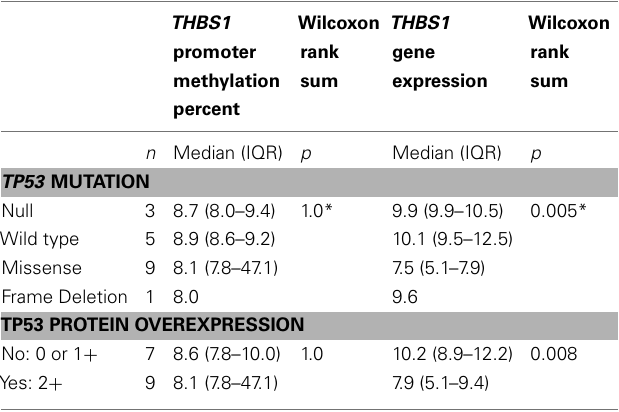
Table 1 | Relationship between THBS1 differential gene expression, promoter methylation, mRNA expression, and TP53 mutations in ovarian cancer cell lines